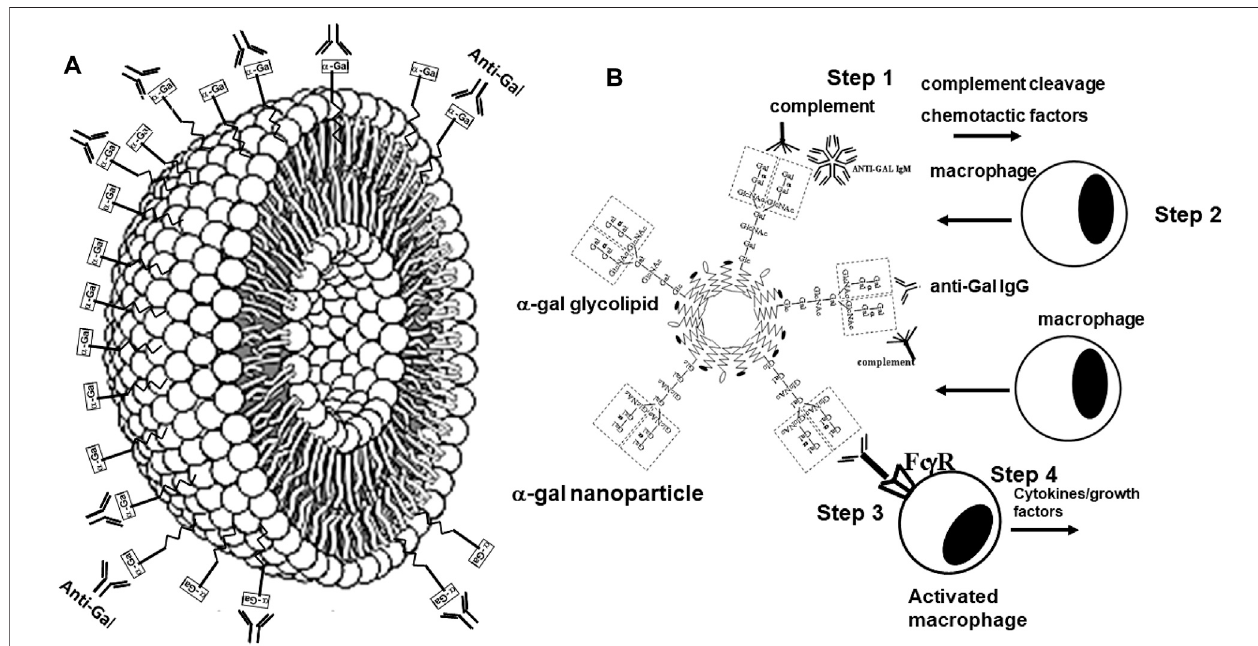
FIGURE6| Structureandbiologicalfunctionsof α -galnanoparticles. (A) α -Galnanoparticles aresubmicroscopic liposomesinwhichmultipleglycolipidswith α -gal epitopes (rectangles) are anchored in a manner similar to that shown in Figure 1A . The natural anti-Gal antibody readily binds to α -gal epitopes on α -gal nanoparticles. (B) Administrationof α -galnanoparticlestowoundsresultsinrecruitmentandactivationofmacrophages(similartorecruitmentandactivationofmacrophagesbyvirus α -gal in Figure 5 ), according to the following steps: (Step 1) binding of the natural anti-Gal antibody to α -gal nanoparticles activates the complement system. (Step 2) Complement cleavage chemotactic factors C5a and C3a induce rapid recruitment of macrophages to the α -gal nanoparticles. (Step 3) Recruited macrophages interact via theirFc γ receptors(Fc γ R)withtheFcportionofanti-Galimmunocomplexedtothe α -galnanoparticles.(Step4)TheFc/Fc γ Rinteractionactivatesmacrophagestosecretea widerangeofcytokinesandgrowthfactorsthatacceleratehealingofthetreatedwoundandpreventscarformation.ReprintedfromGaliliU. Thenaturalanti-Galantibodyas foe turned friend in medicine. Publishers Academic Press/Elsevier, London, 2018, with permission.